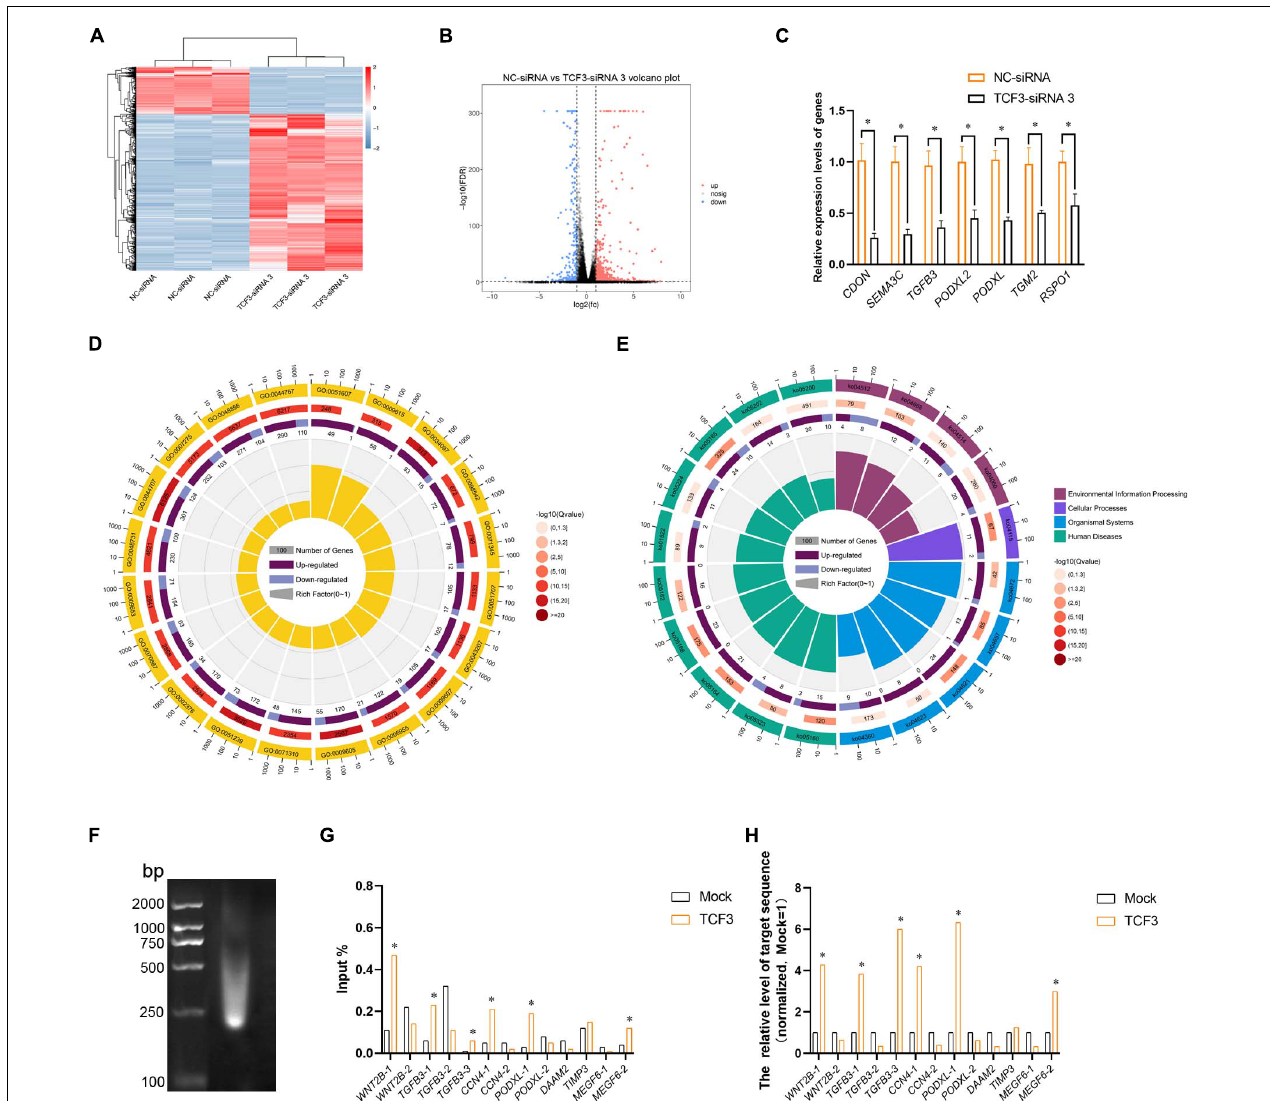
FIGURE 5 | Identification of the target genes of TCF3. (A) hierarchical clustering demonstrated the differentially expressed genes (DEGs) in the human SSC line between NC-siRNA and TCF3-siRNA 3. (B) Volcano plot illustrated the differentially expressed mRNAs. (C) qPCR evaluated the changes in CDON , SEMA3C , TGFB3 , PODXL2 , PODXL , TGM2, and RSPO1 mRNA in the human SSC line by TCF3-siRNA 3 and the NC-siRNA. * p < 0.05 indicated the significant differences between TCF3-siRNA 3 and NC-siRNA. (D) GO circle plot illustrated the top 20 enrichment terms. First circle: GO terms of the top 20 enrichments, and outside circle was the sitting scale of the number of genes. Different colors denoted the different ontologies; the second circle: the number of DEGs was enriched in this GO term and the Q -value. The more genes, the longer the bar, the smaller the Q -value, and the red the color; the third circle: the bar chart of the proportion of DEGs, and dark purple denoted the fraction of up-regulated genes. Light purple signified the proportion of down-regulated genes, and the specific value was indicated below; the fourth circle: Rich Factor value of each GO term (the number of differences in this GO term was divided by all the numbers), background grid line, each grid indicated 0.1. (E) KEGG circle plot for top 20 enrichment pathways. The first circle: top 20 enriched pathways, outside circle was the coordinate scale of gene number, and different colors signified different A classes; the second circle: the number of DEGs enriched in this GO term and the Q -value. The more genes, the longer the bar, the smaller the Q -value, and the red the color; the third circle: the bar chart of the proportion of DEGs, while dark purple indicated the fraction of up-regulated genes, while light purple represented the proportion of down-regulated genes, the specific value was indicated below; the fourth circle: Rich Factor value of each pathway (the number of differences in this pathway was divided by all the numbers), background grid line, each grid denoted 0.1. (F) Gel electrophoresis of DNA after ultrasonication. (G,H) qPCR evaluation of the ChIP enriched DNA samples using specified promoter or enhancer primers. Mock, negative mouse IgG control. ∗ p < 0.05 indicated the significant difference from